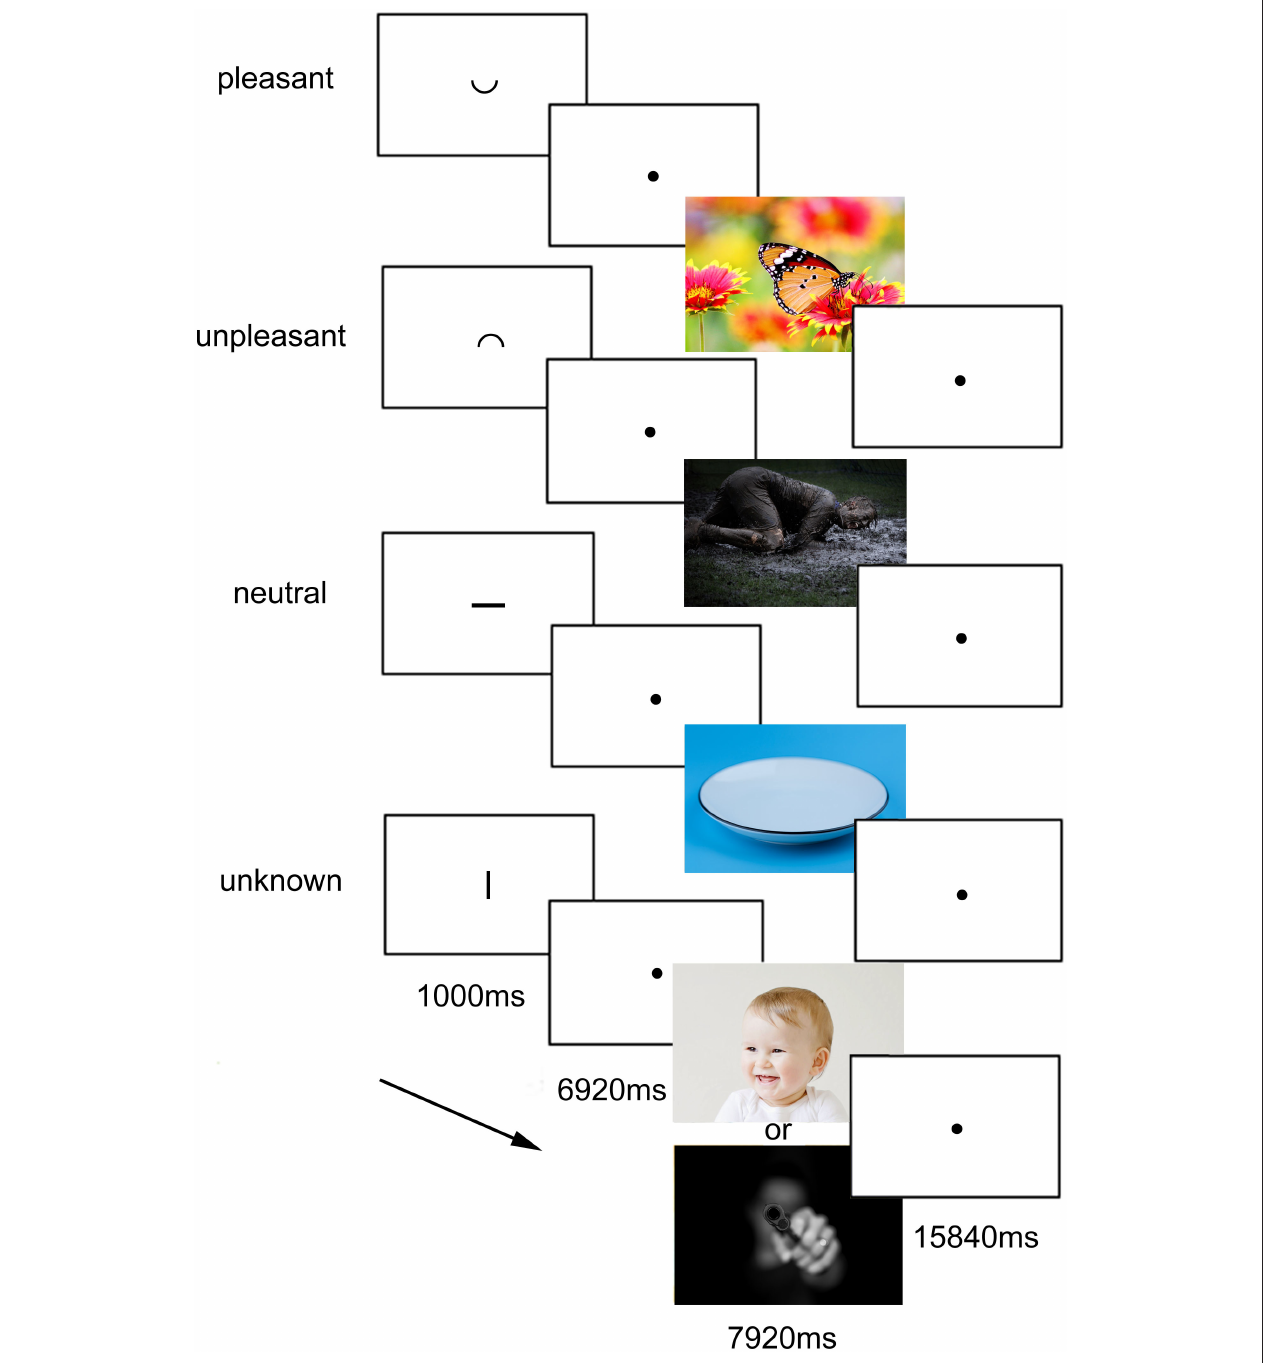
FIGURE 1 | Experimental task. The four conditions with the respective cues and the duration are presented. The cues, presented for 1,000ms, indicated the valence of the following picture, appearing after a delay of further 6,920ms. In the figure, the cues are relatively enlarged for presentation reasons. In the experiment, they were about 1/40 of screen height. The experimental task design was identical to the one used and published before by Herwig et al. (24). The images used in the task came from the IAPS (International affective picture system), for which publication is not permitted, so for illustrative purposes here pictures under CC0 license are displayed. valence of the presented pictures during the scan on a nine- point rating scale (shown again as printouts, 1—very negative, 9—very